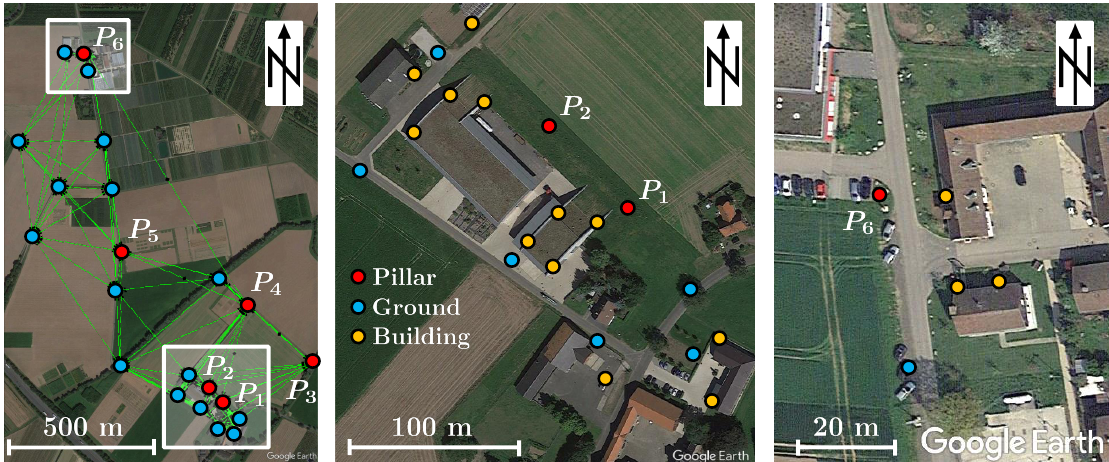
Figure 13. Network of control points with six pillars, 15 building points, and 16 ground points. The control points can be signalized with BOTA8 (Bonn Target 8) laser scanning targets (Source: Google Earth, modified).